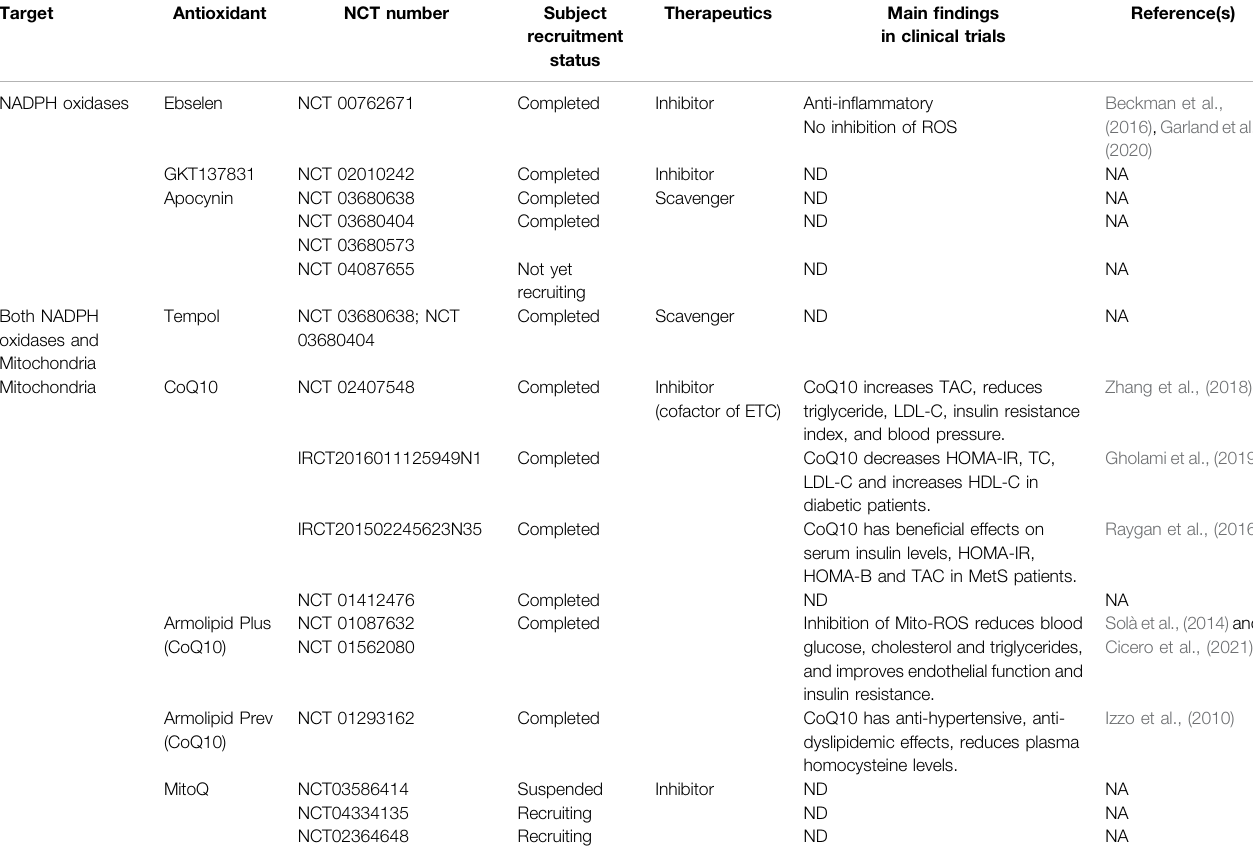
TABLE 2 | Clinical trials of antioxidants in the therapy of metabolic syndrome or associated cardiovascular and chronic renal